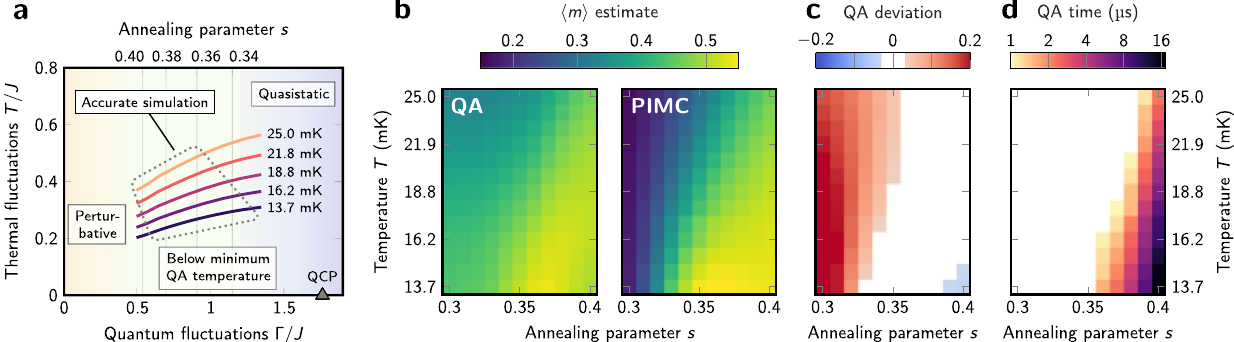
Fig. 3 Region of accurate simulation and resolvable dynamics. a Our QA experiments are parameterized by annealing parameter s and physical temperature T ; these map to the familiar ( T / J , Γ / J ) plane as shown. b Estimates of m h i are shown for QA and PIMC quenched samples for a range of T and s . c QA deviation from PIMC estimates is shown. When relaxation is extremely fast, order in the system is severely overestimated due to ordering during the readout quench. The white region falls within a tolerance of 0.03 of the ground truth, which corresponds to our “ accurate simulation ” region in a . At low T and high s , transverse fi eld is small and ordering is weak, and therefore easily suppressed by inhomogeneities in the processor. d We cannot resolve convergence timescales faster than 1 μ s. Our parameter range is therefore further restricted, excluding the fastest-converging models, i.e., those with high T and low s , shown in